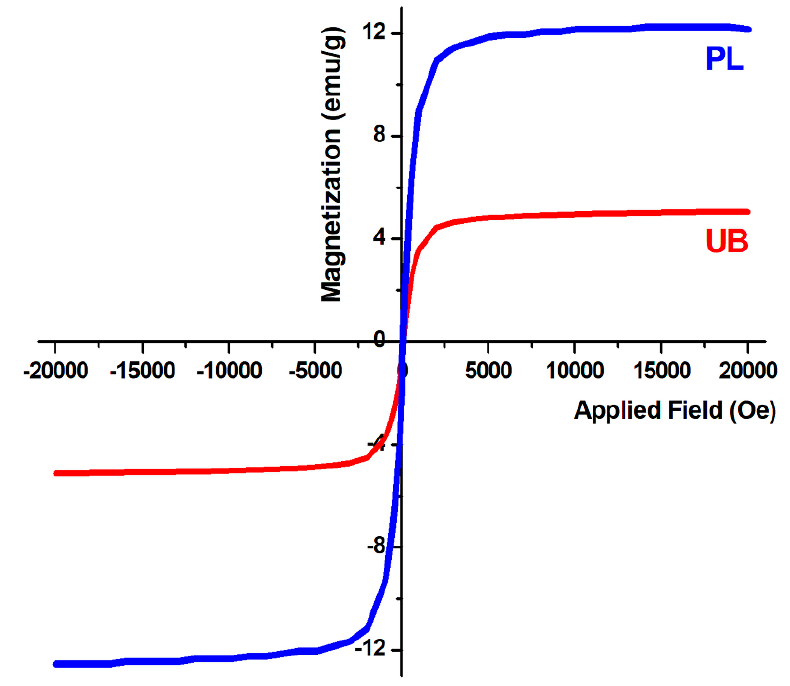
Figure 2. Magnetization vs. applied magnetic field for samples particles at 300 K.